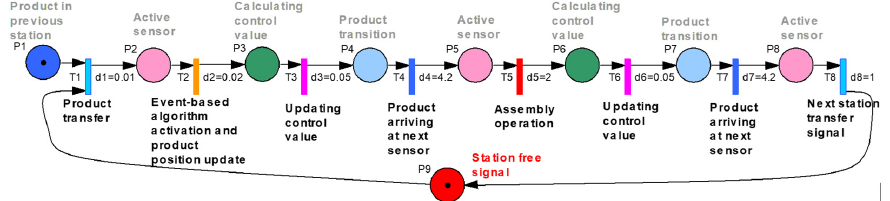
Figure 9. Modeling of the control algorithm in workstation operation.